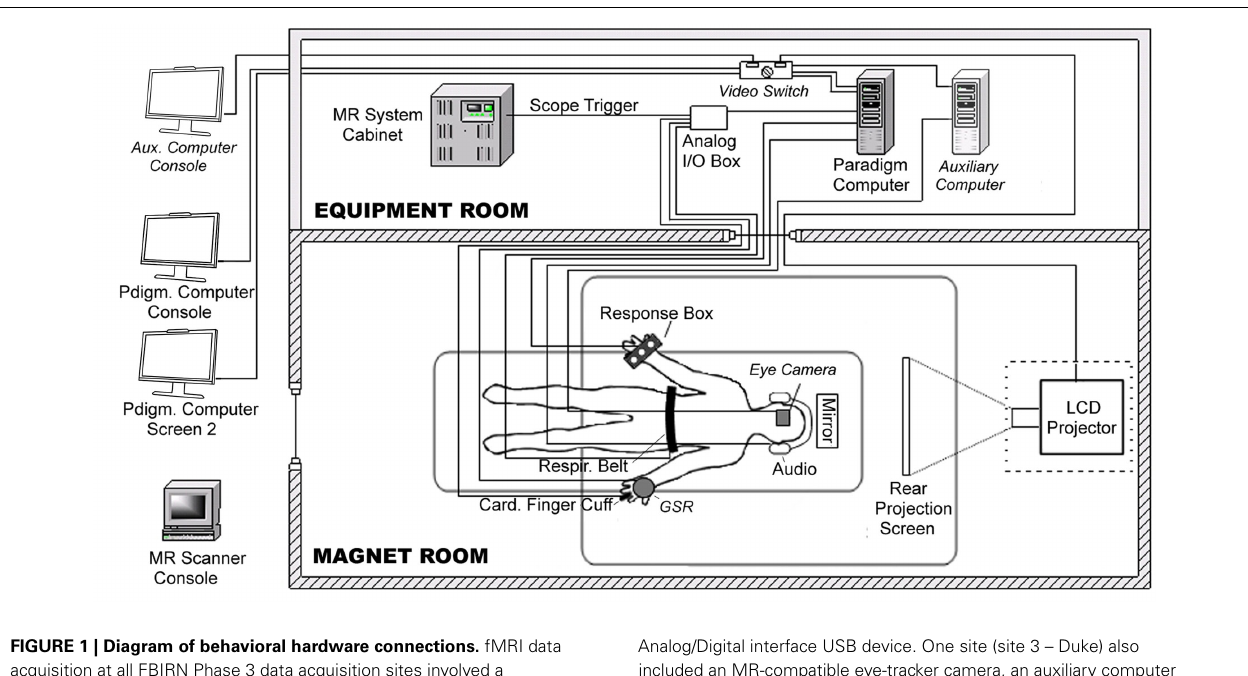
FIGURE 1 | Diagram of behavioral hardware connections. fMRI data acquisition at all FBIRN Phase 3 data acquisition sites involved a paradigm control computer (Windows OS) with dual video monitors, a video projector, a scanner trigger cable, a manual response button box, a respiratory belt transducer, a cardiac finger pulse-oximeter and associated Biopac amplifier, and a Measurement Computing